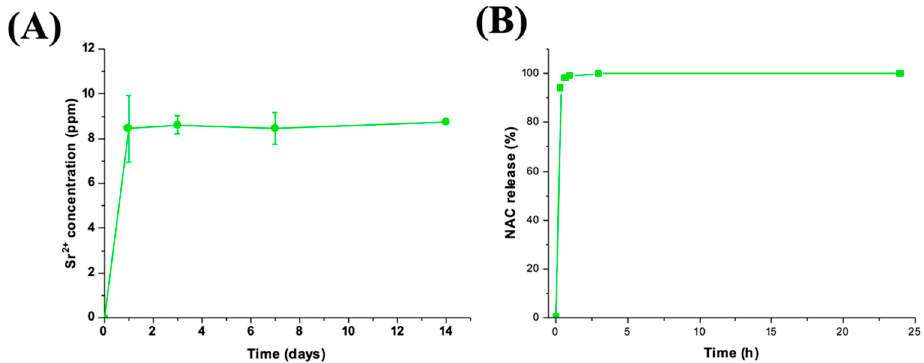
Figure 11. Released ppm of Sr 2+ ions ( A ) and percentage of NAC released ( B ) from MBG_Sr_NAC in Tris-HCl.